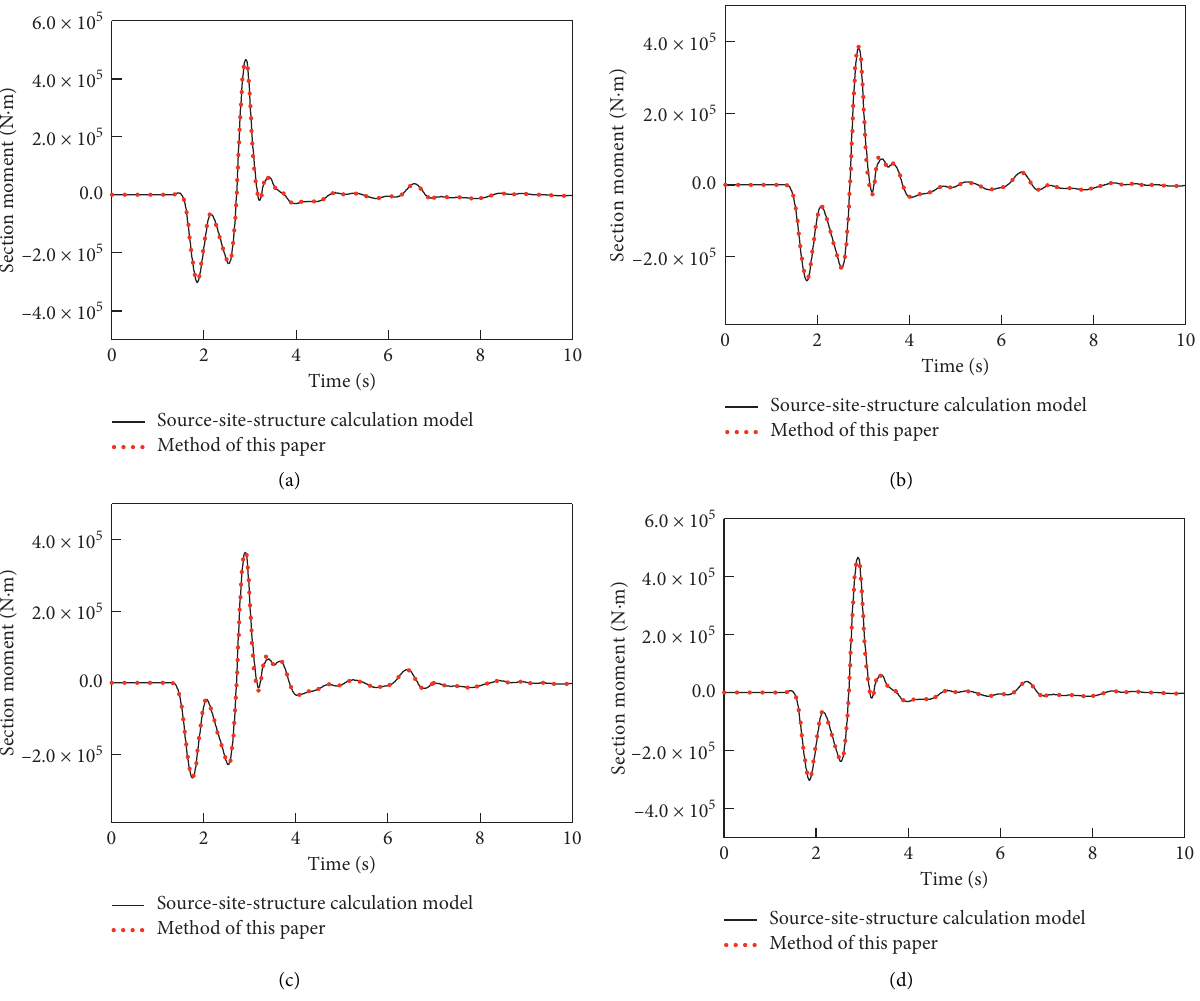
Figure 13: Comparison of bending moments of the structural section (burial depth is 20m): (a) section (A), (b) section (B), (c) section (C), and (d) section D.